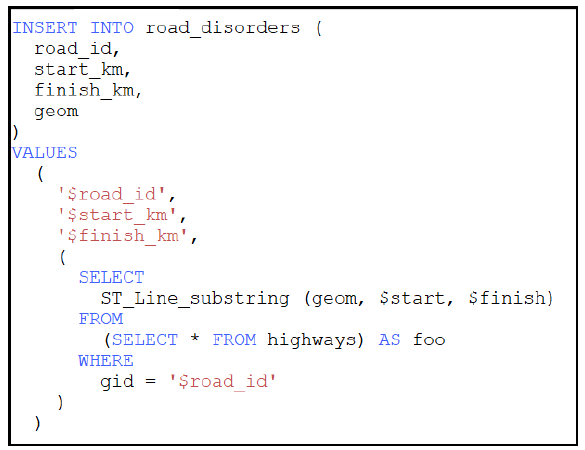
Figure 15. Segmenting geometry data with PostGIS functions